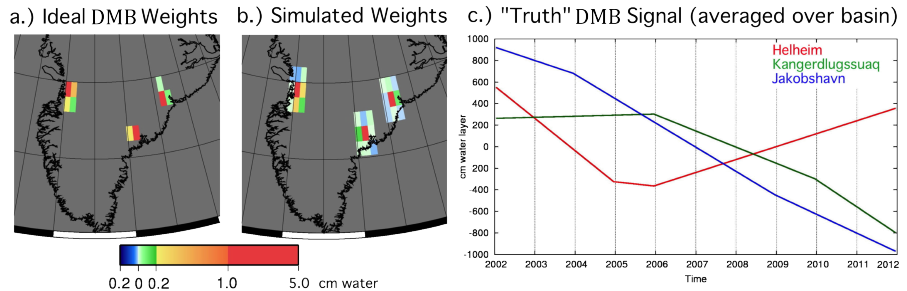
Figure 4. (a) Ideal DMB weights used as basin definitions, (b) an example of the relative weights used in the DMB truth data, and (c) the truth DMB signal for each